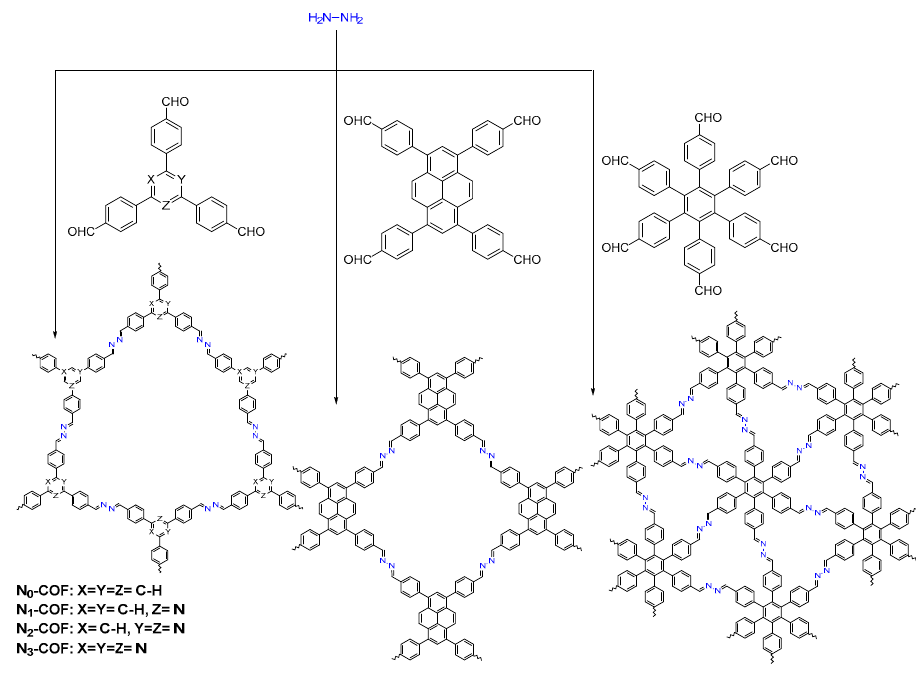
Figure 20. Synthetic reaction of azine-linked COFs (Py-Azine COF, HEX-COF 1, and N x -COF).